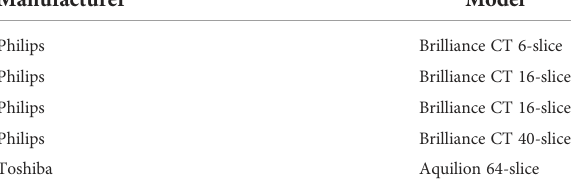
TABLE 1 CT scanners used in this